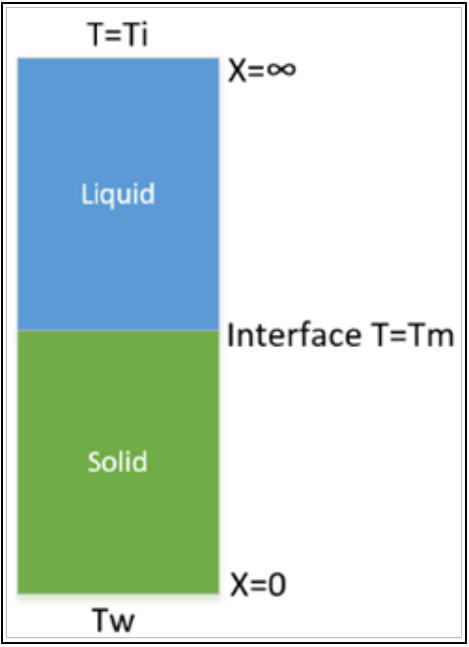
Figure 3. Moving front.